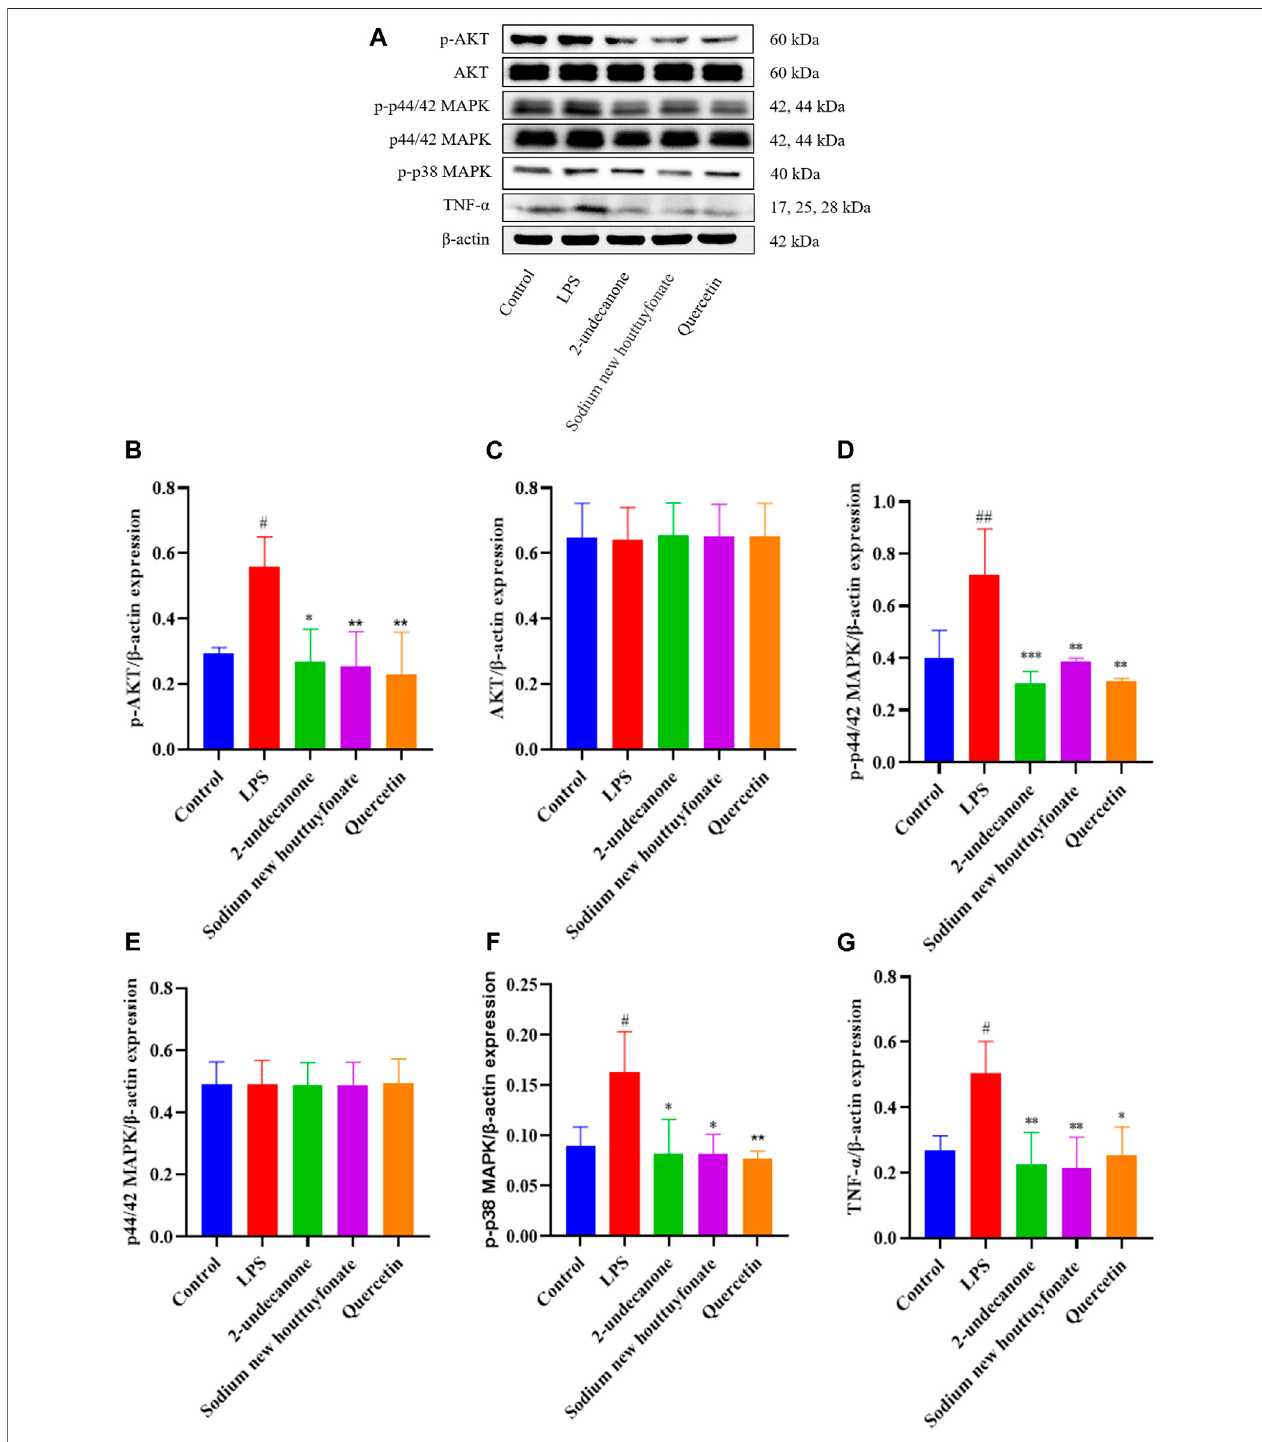
FIGURE 9 | Effects of 2-undecanone, sodium new houttuyfonate, and quercetin on the protein expression of AKT, p-AKT, p44/42 MAPK (ERK1/2), p-p44/42 MAPK (ERK1/2), p-p38 MAPK, and TNF- α of LPS-induced A549 cells (A – G). # p < 0.05, ## p < 0.01, compared with the control group. * p < 0.05, ** p < 0.01, compared with the LPS